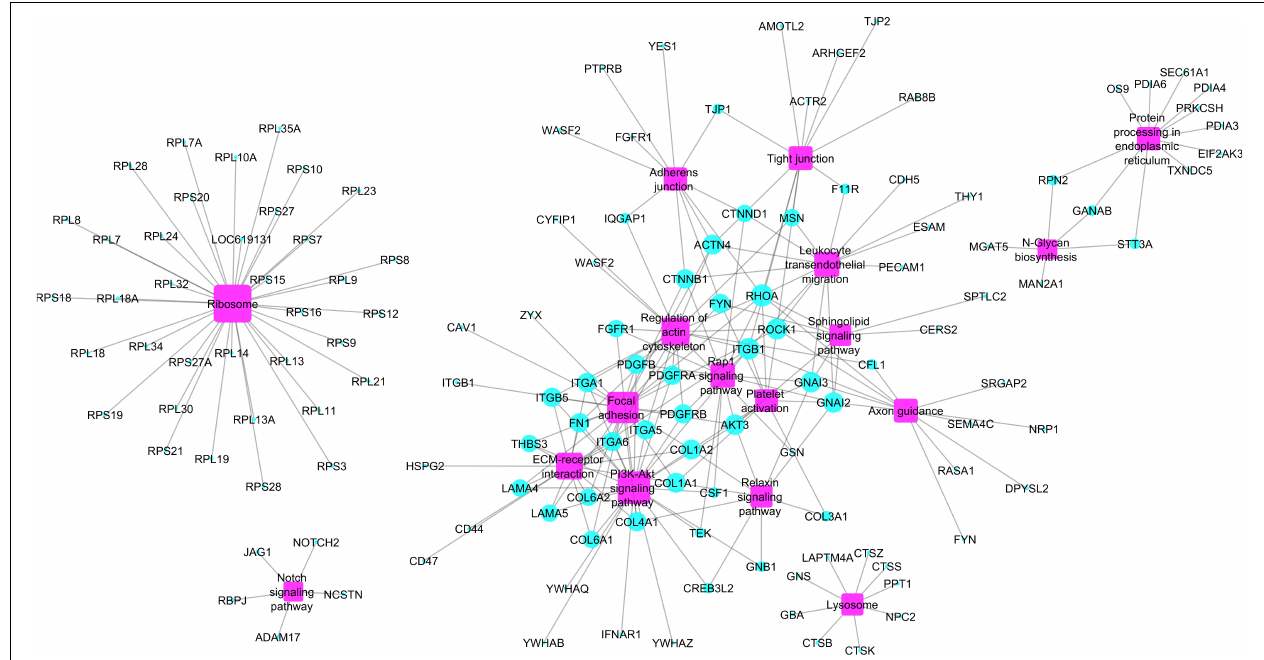
FIGURE 4 | Network hub genes and enriched pathways identified by ClueGO software. The size of the purple squares (pathways) represents the connectivity degree of the nodes (turquoise circles representing hub genes) based on the number of connections to the pathways.